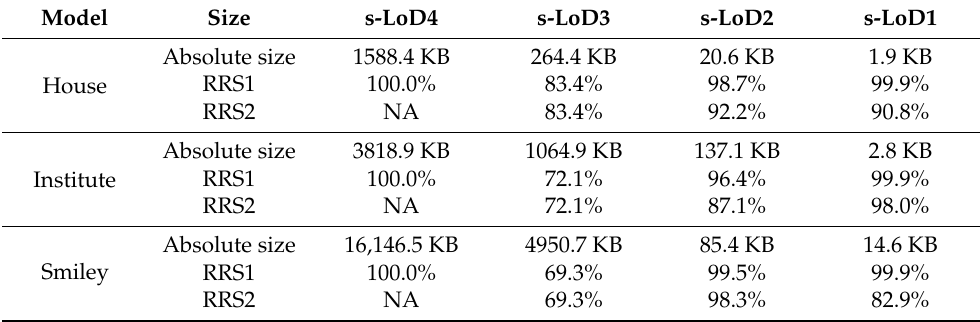
Table 7. Size of models from s-LoD1 to s-LoD4 for house, institute and Smiley